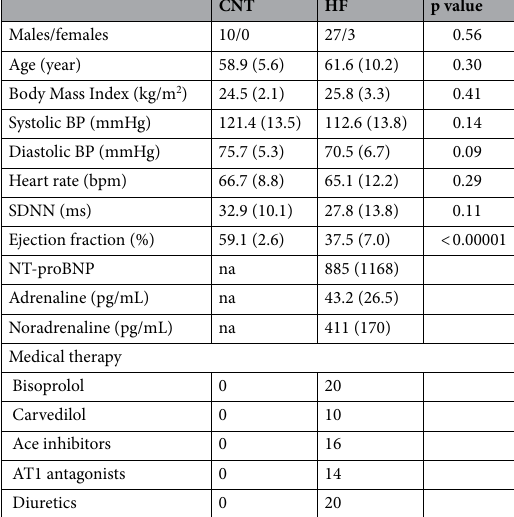
Table 1. General data on patients and controls with significance p of their difference. Values as mean (SD); p after Fisher’s exact test for sex composition, otherwise after Mann Whitney U test; BP blood pressure in sitting position by an arm cuff, heart rate and SDNN in supine position, NT-proBNP N-terminal prohormone of brain natriuretic peptide, CNT controls, CHF congestive heart failure